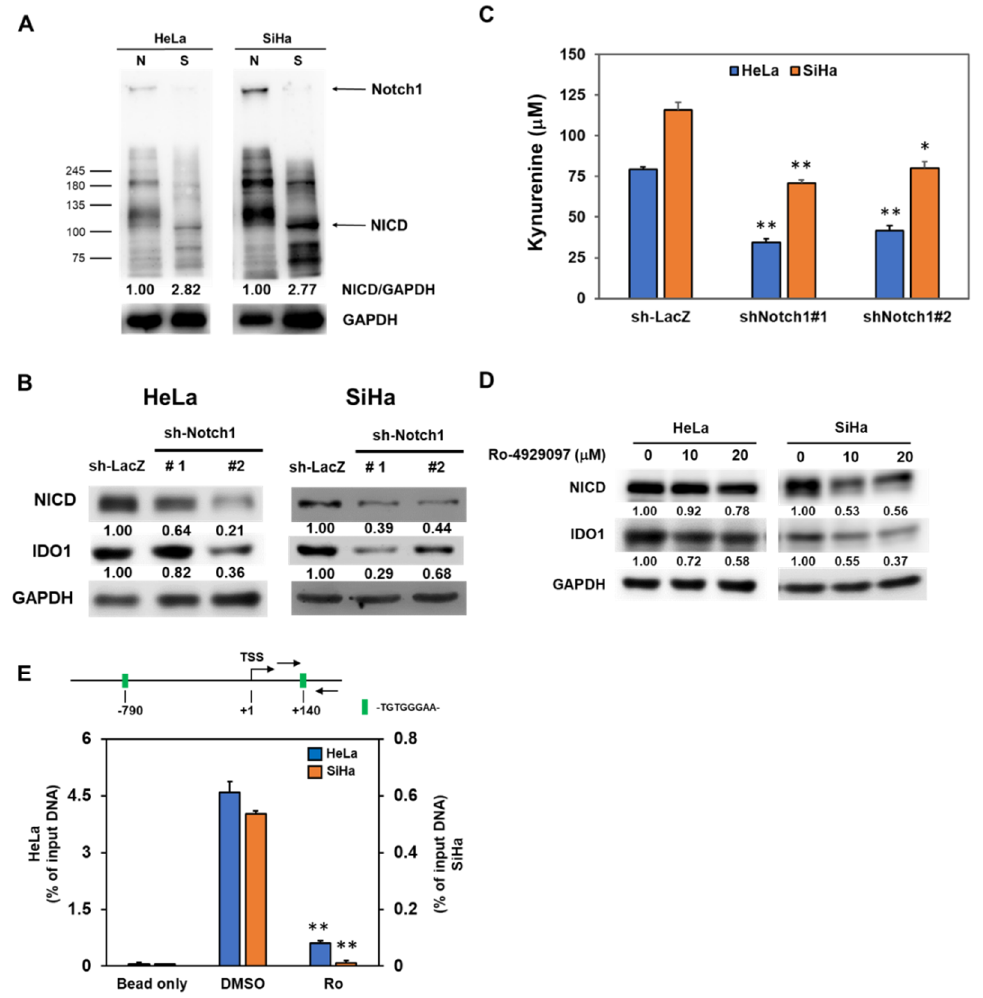
Figure 3. Notch1 activation in cervical CSCs participates to the IDO1 induction. ( A ) Total cell lysates were collected from conventional adherent culture (N) or tumorspheres (S) from HeLa and SiHa cells and the expression of Notch1 and NICD was determined by Western blotting. ( B – D ) Tumorspheres from HeLa and SiHa cells were dissociated into single cell suspension and were transduced with lentiviruses carrying Notch1 specific shRNAs (sh-Notch1#1 or sh-Notch1#2) followed by puromycin selection. The surviving cells were collected and detected the expression of NICD or IDO1 by Western blotting ( B ). The insert numbers indicate the relative expression level in comparison to sh-LacZ transduced cells. The kynurenine concentration in the culture supernatant was determined by Ehrlich’s reagent ( C ). * p < 0.05; ** p < 0.01. Tumorsphere cells were treated with Ro-4929097 as the indicated concentration and detected the expression of NICD or IDO1 by western blot ( D ). The insert numbers indicate the relative expression level in comparison to 0.1% DMSO control (labeled as 0 µ M). ( E ) The putative binding site of RBPJ / CSL (-TGTGGGAA-) in IDO1 promoter was analyzed by the Eukaryotic Promoter Database (EPD) website and the binding of NICD to the RBPJ / CSL binding site of IDO1 promoter at + 140 site in HeLa and SiHa tumorsphere cells was detected by the chromatin immunoprecipitation (ChIP) method with an anti-Notch1 antibody and quantitated by the qPCR method. Data were presented as percentage of input DNA. ** p < 0.01. All the experiments were repeated three times and the data from one experiment were presented.